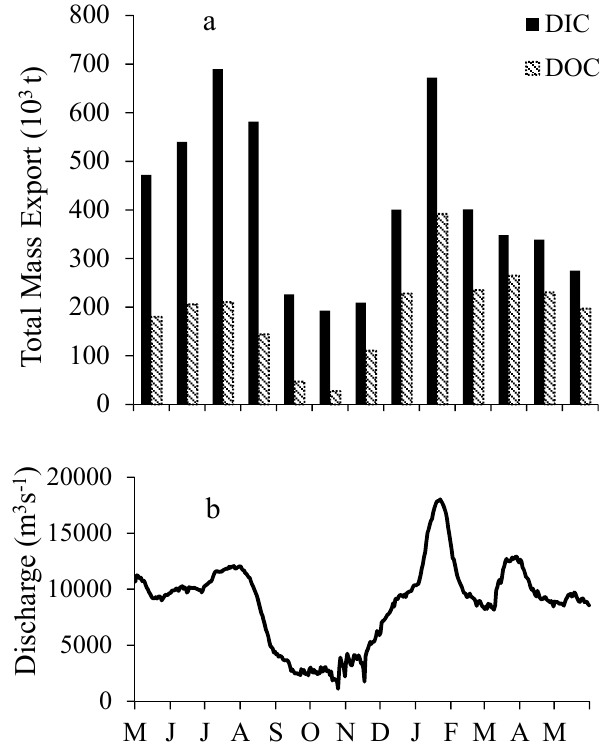
Figure 7. ( a ) Monthly mass export of DOC and DIC from the Atchafalaya River’s two outlets, Wax Lake outlet and Morgan City, into the Northern Gulf of Mexico during the period from May 2015 to May 2016; ( b ) corresponding with daily combined average discharge from the two outlets.